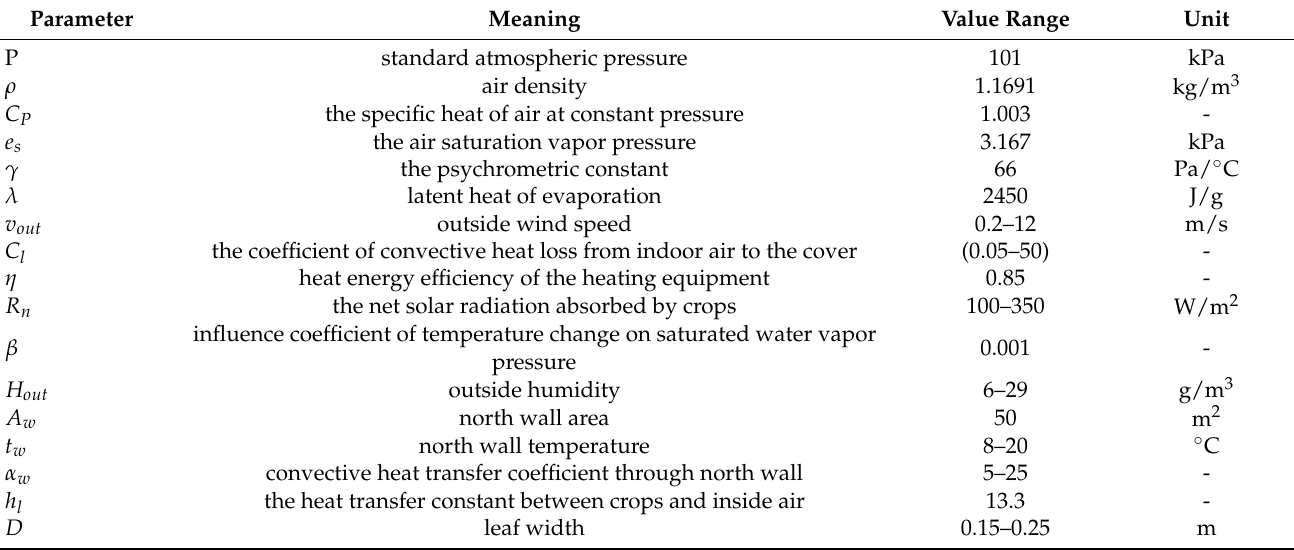
Table A1. Meanings of parameters of the greenhouse temperature